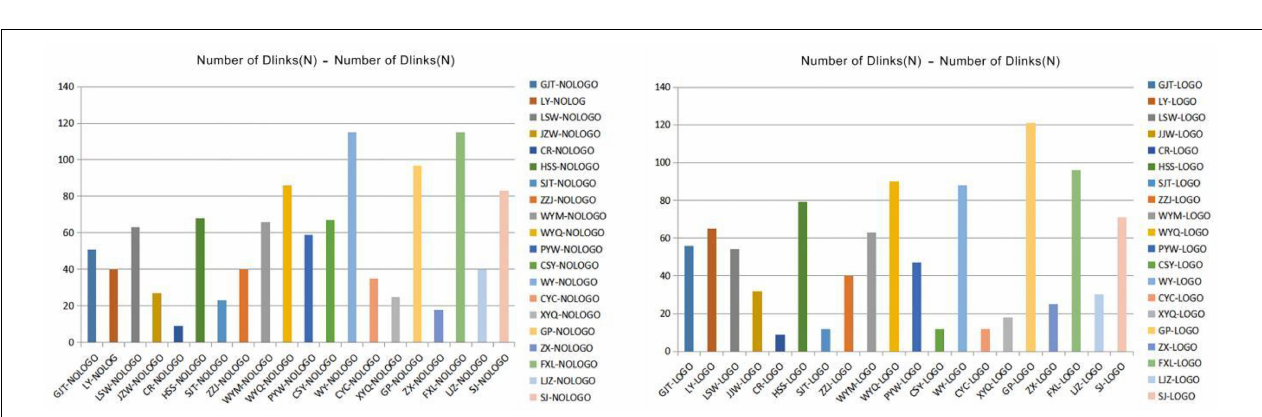
FIGURE 9 | Experimental records of individual samples in ErgoLab (Search and take screenshots from ErgoLab by our research team).